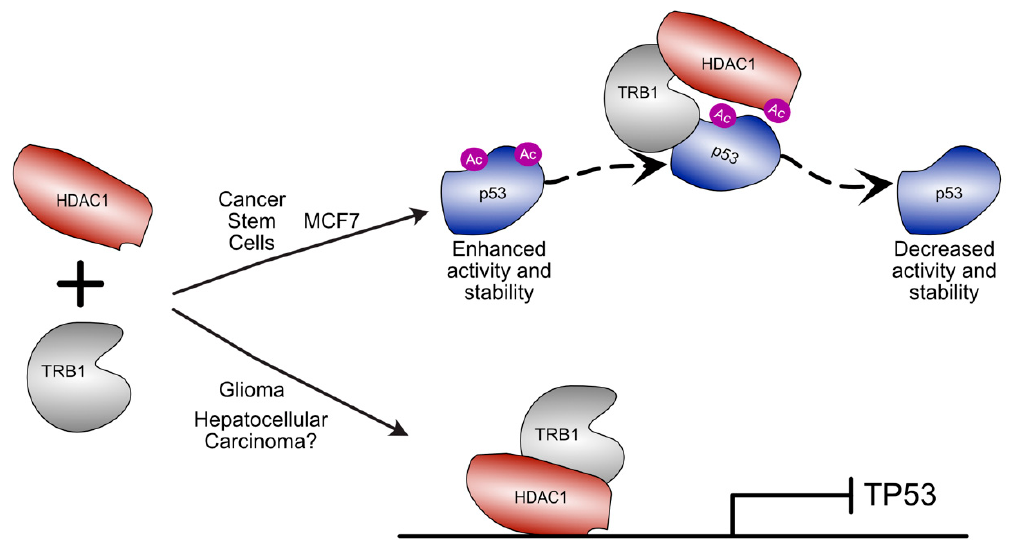
Figure 4. Schematic illustration of divergent roles for TRIB1–HDAC1 complexes in different cancer types. In cancer stem cells derived from non-small-cell lung cancer and in MCF7 breast cancer cells, TRIB1 can mediate destabilisation of p53 by scaffolding an interaction between HDAC1 and p53 resulting in p53 deacetylation. In glioma and hepatocellular carcinoma, TRIB1–HDAC1 has been shown to regulate TP53 expression. In glioma TRIB1 and HDAC1 colocalise to the TP53 promoter to modulate expression.